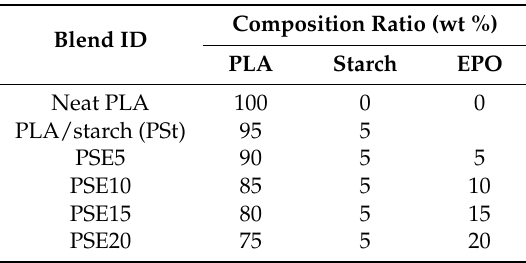
Table 1. Composition and ratio of polylactic acid (PLA), starch, and epoxidized palm oil (EPO) in the PLA/starch/EPO (PSE)